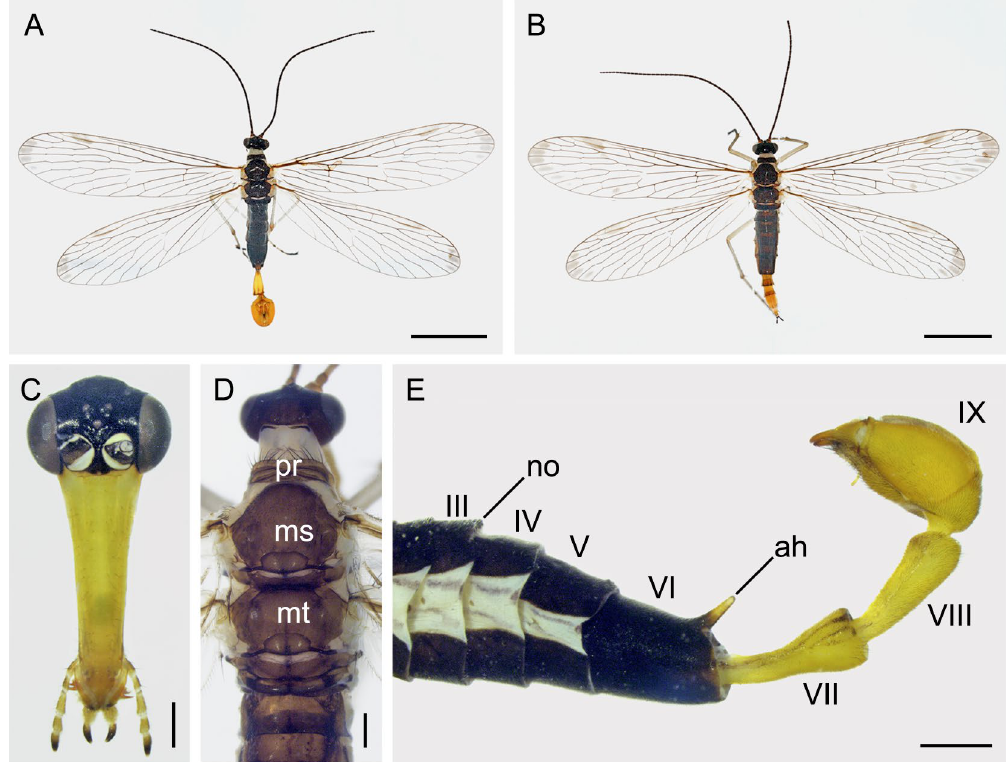
Fig. 9. Adults of Cerapanorpa xuebaodinga sp. nov. A . Male habitus in dorsal view. B . Female habitus in dorsal view. C . Male head with antennae removed in frontal view. D . Dorsum of male. E . Male abdomen in lateral view. Abbreviations: ah = anal horn; ms = mesonotum; mt = metanotum; no = notal organ; pr = pronotum. Scale bars: A–B = 5 mm; C–D = 0.5 mm; E = 1